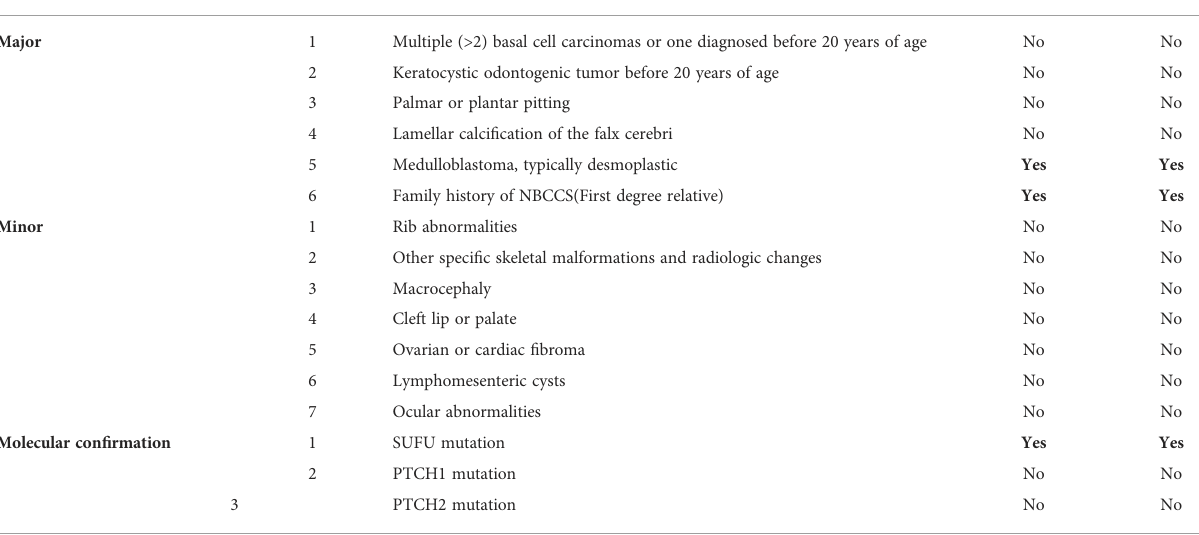
TABLE 1 Criteria for Gorlin-Goltz